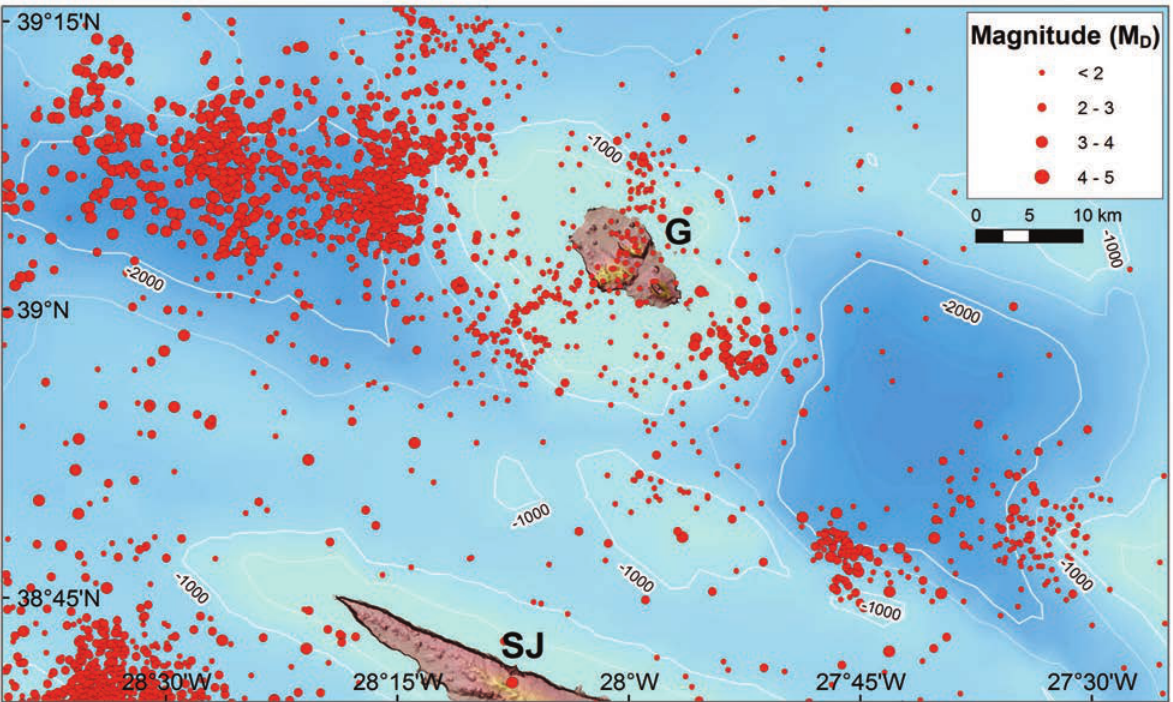
Figure 4. Seismicity in Graciosa region from 2002 to 2012. The red dots mark epicentres of earthquakes and its magnitude. Plot includes earth- quakes of all magnitudes. G - Graciosa Island; SJ - São Jorge Island. Data from CIVISA (Centro de Informação e Vigilância Sismovulcânica dos Açores), 2012.